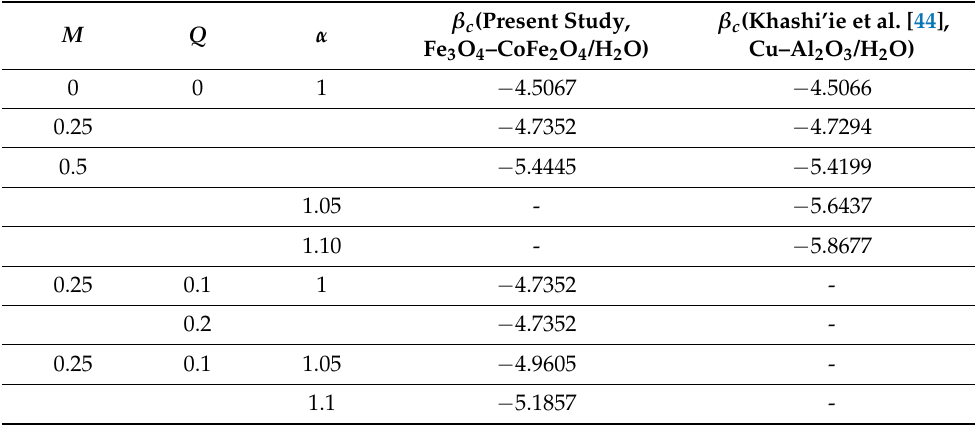
Table 5. Comparison of β c with Khashi’ie et al. [44] when φ 1 = φ 2 = 0.01, with various